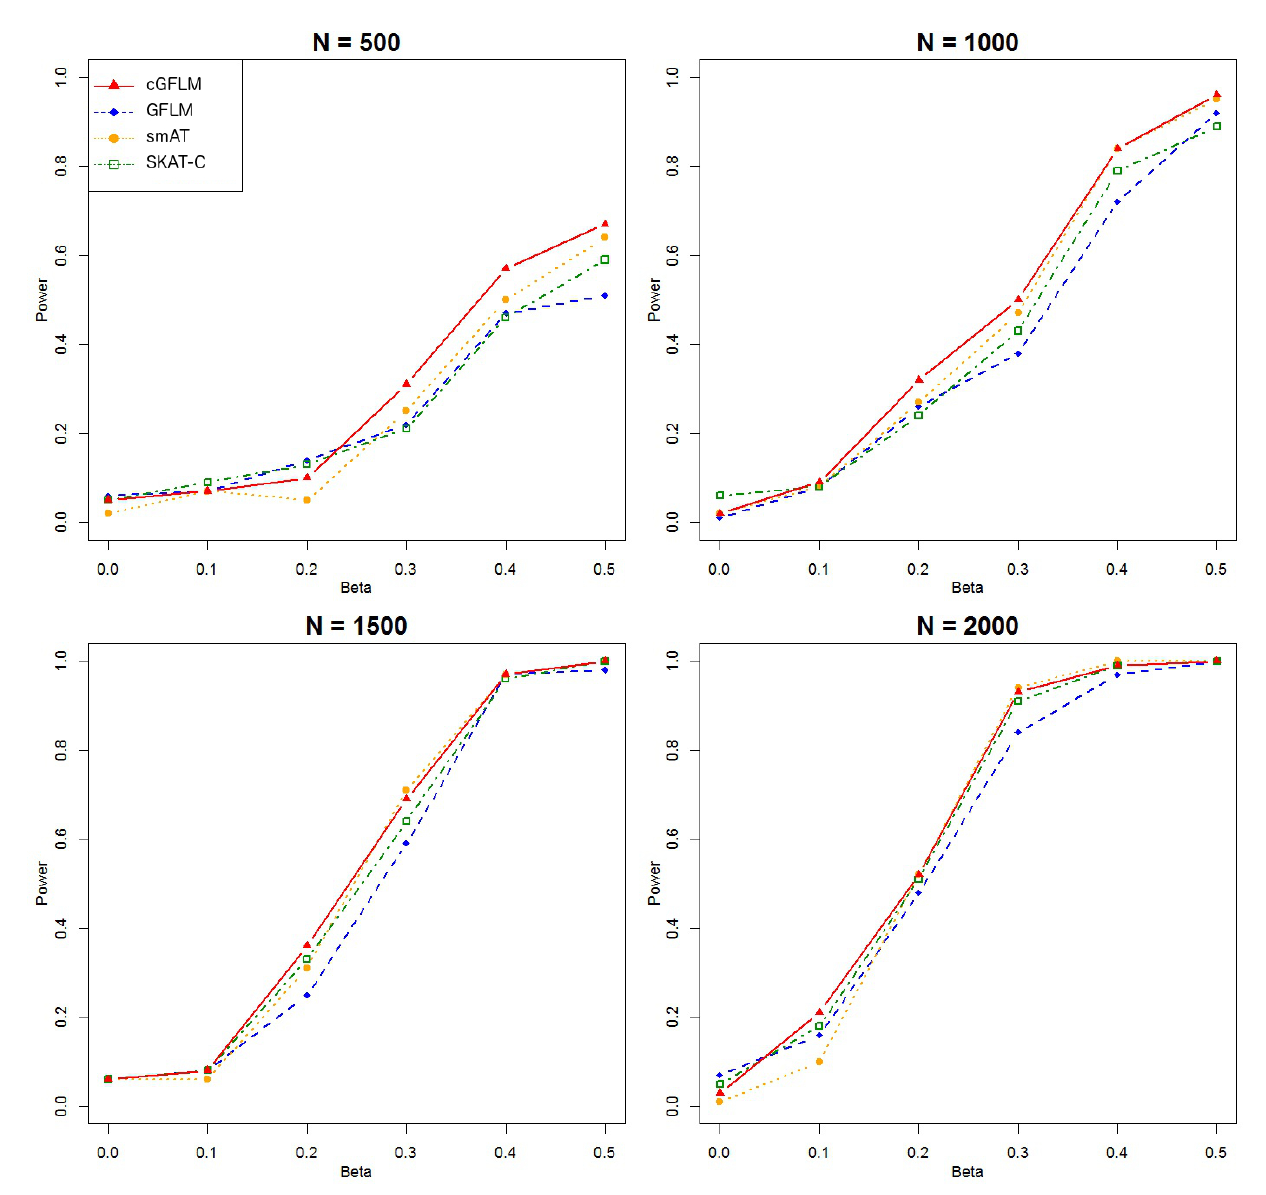
Figure A2. Power simulation for binary outcomes based on the CHRNA7 gene, two reverse-sign causal